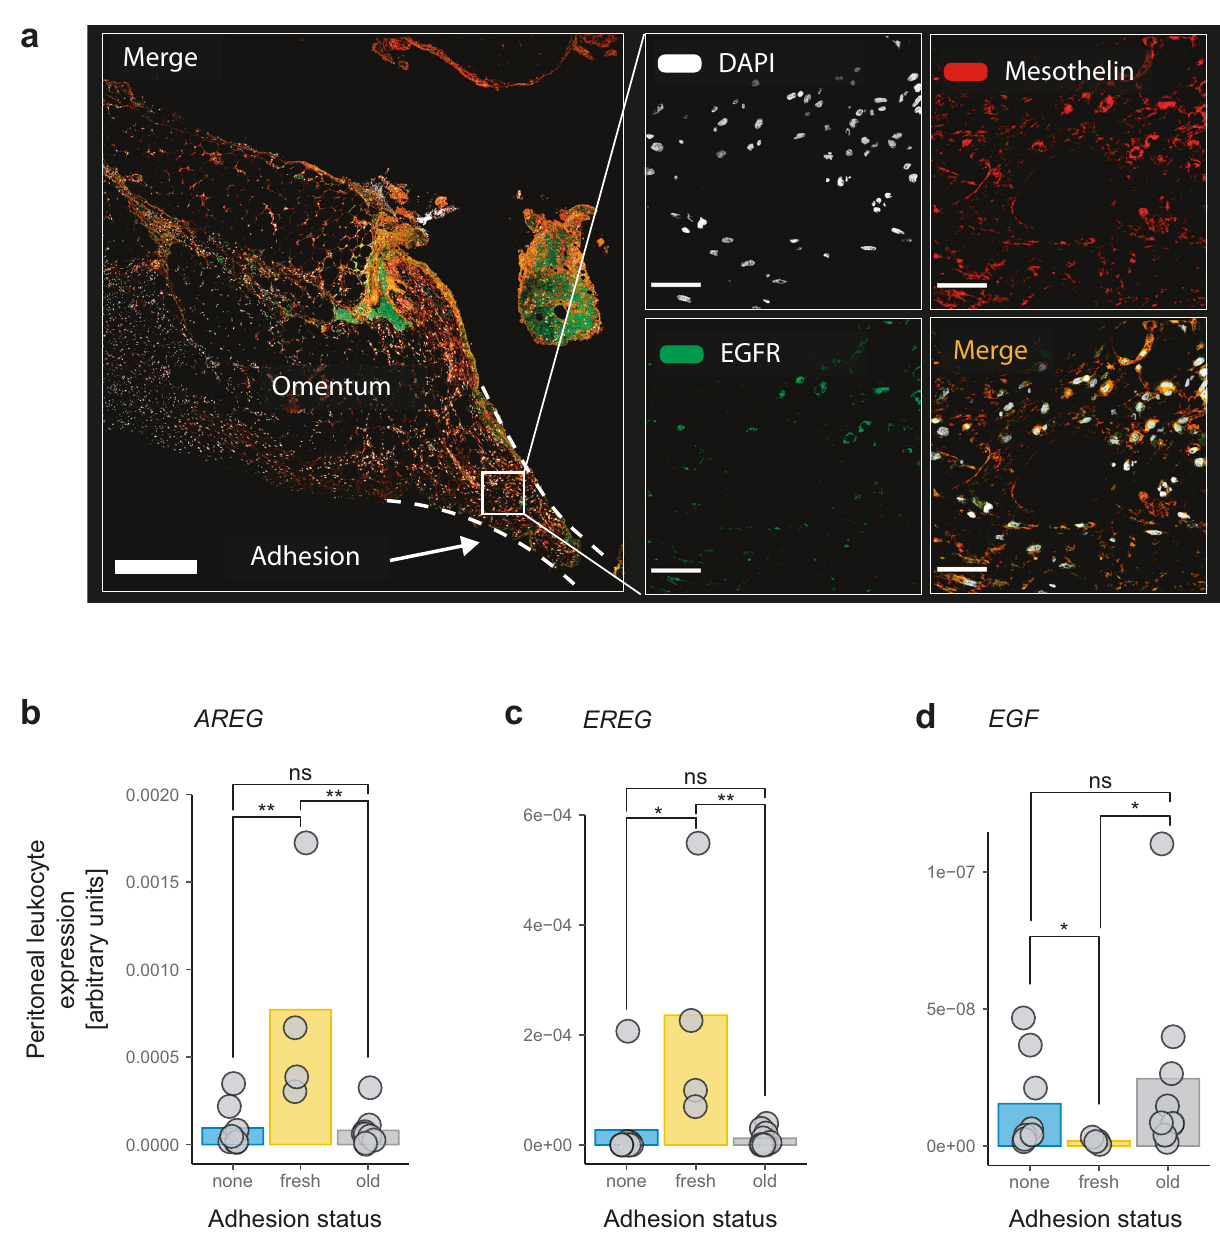
Fig. 8 Human patients with adhesions have EGFR positive cells of mesothelial origin in them and an elevated EGFR-agonist expression in their peritoneal leukocytes. a Biopsy from a patient with a fresh adhesion (13 days after initial surgery) stained for mesothelin and epidermal growth factor receptor (EGFR). Image depicts omental tissue that was adherent to a piece of intestine (the latter could not be included in the biopsy). Magni fi cation shows cells that are double positive for mesothelin and EGFR. Scale bar overview: 500 um, Scale bar magni fi cation: 50 µ m. Images are representative of n = 4 human patients. b – d Peritoneal leukocytes were isolated from patients with no, fresh or old adhesions. Expression of EGFR ligand genes was measured by quantitative polymerase chain reaction. ( b ) amphiregulin ( AREG ), none vs. fresh: p = 0.0081, none vs. old: p = 0.96, fresh vs. old: p = 0.0056. c epiregulin ( EREG ), none vs. fresh: p = 0.016, none vs. old: p = 0.24, fresh vs. old: p = 0.0028. ( d ) epidermal growth factor ( EGF ), none vs. fresh: p = 0.028, none vs. old: p = 0.48, fresh vs. old: p = 0.02, Data are represented as mean and individual symbols. Data represent n = 8 for none, 4 for fresh, and 9 for old individual patients of one independent cohort study. Patient demographics according to Supplementary Table 2. Indicated statistical differences by Wilcoxon test (two-sided) with Holm-Bonferroni correction for multiple-testing. * P < 0.05, ** P < 0.01, n.s. P ≥ 0.05. Source data are provided as a Source Data fi